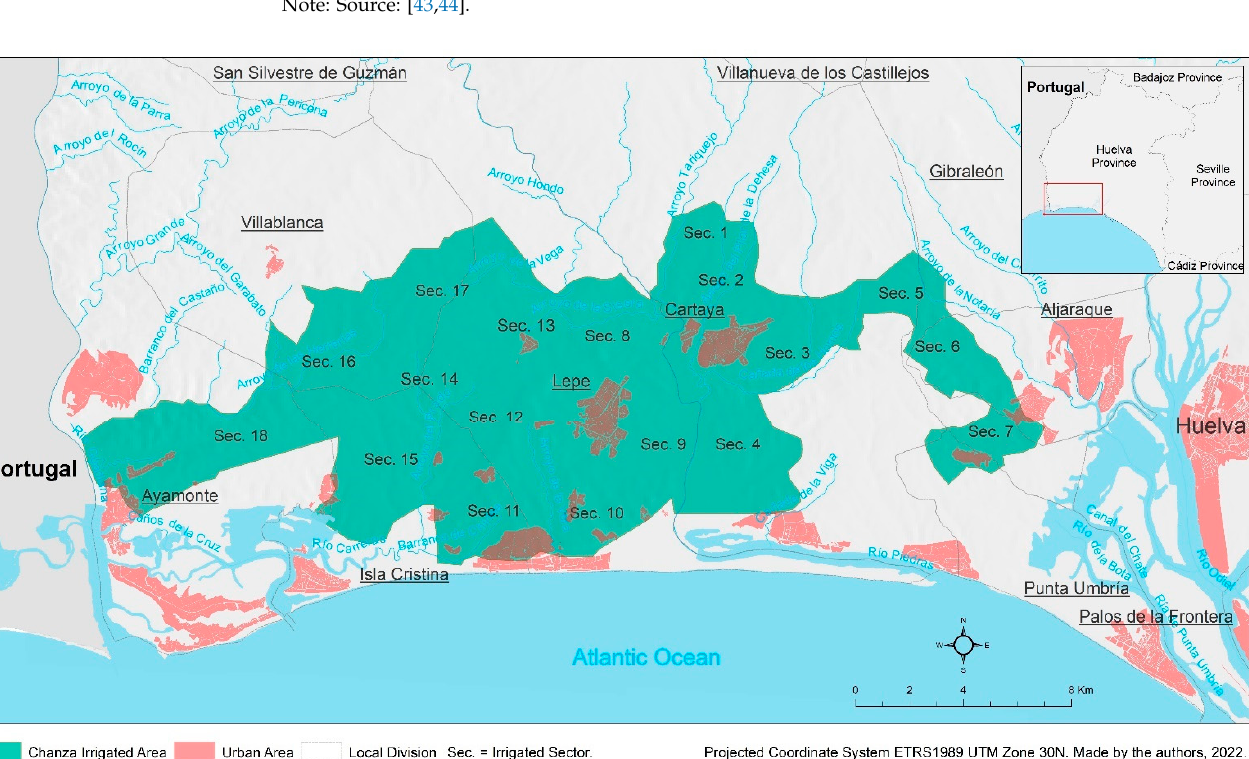
Figure 2. Chanza Irrigable Area. (Source: [49]).